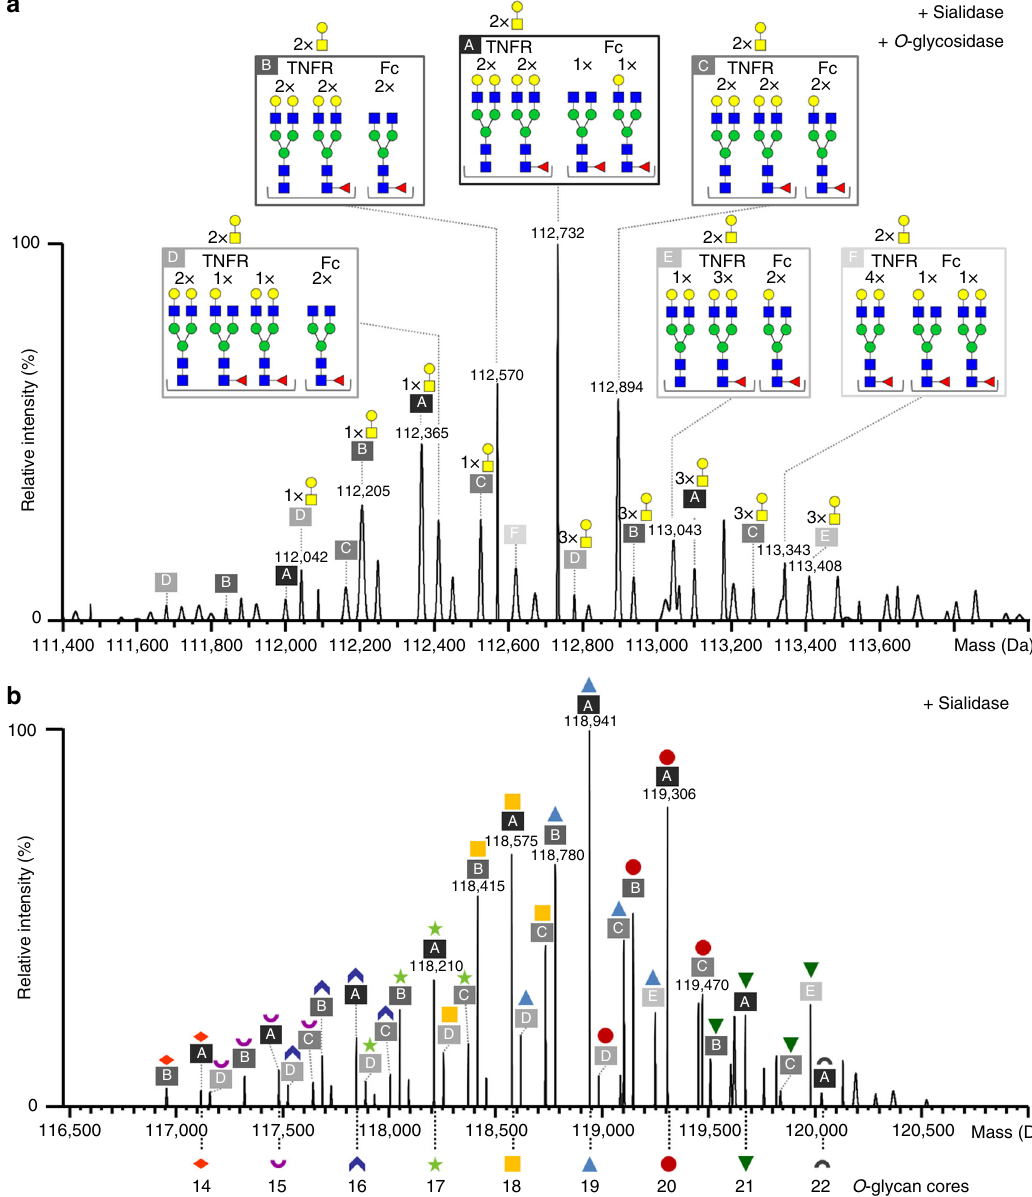
Fig. 4 N - and O -glycosylation of Etanercept lacking sialic acids. a Deconvoluted spectrum of Etanercept treated with sialidase and O -glycosidase acquired under native conditions (raw spectrum is shown in Supplementary Fig. 8b). The most probable glycan structures lacking sialic acids are annotated. The six most abundant N -glycoforms are boxed and marked as A to F, respectively. b Deconvoluted spectrum of sialidase-treated Etanercept upon native MS (raw spectrum is shown in Fig. 1d). The most probable glycoforms are annotated. N -glycan structures are referred to as A to F as speci fi ed in Fig. 4a; O - glycoforms are labeled according to Fig. 2a. Peak lists with all possible glycoform assignments are available in Supplementary Data 1 abundant sialylation variants arise from O -glycoforms substituted with 18 – 21 core 1 O -glycan units (yellow squares, blue triangles, red circles, and dark green triangles in Fig. 2b).